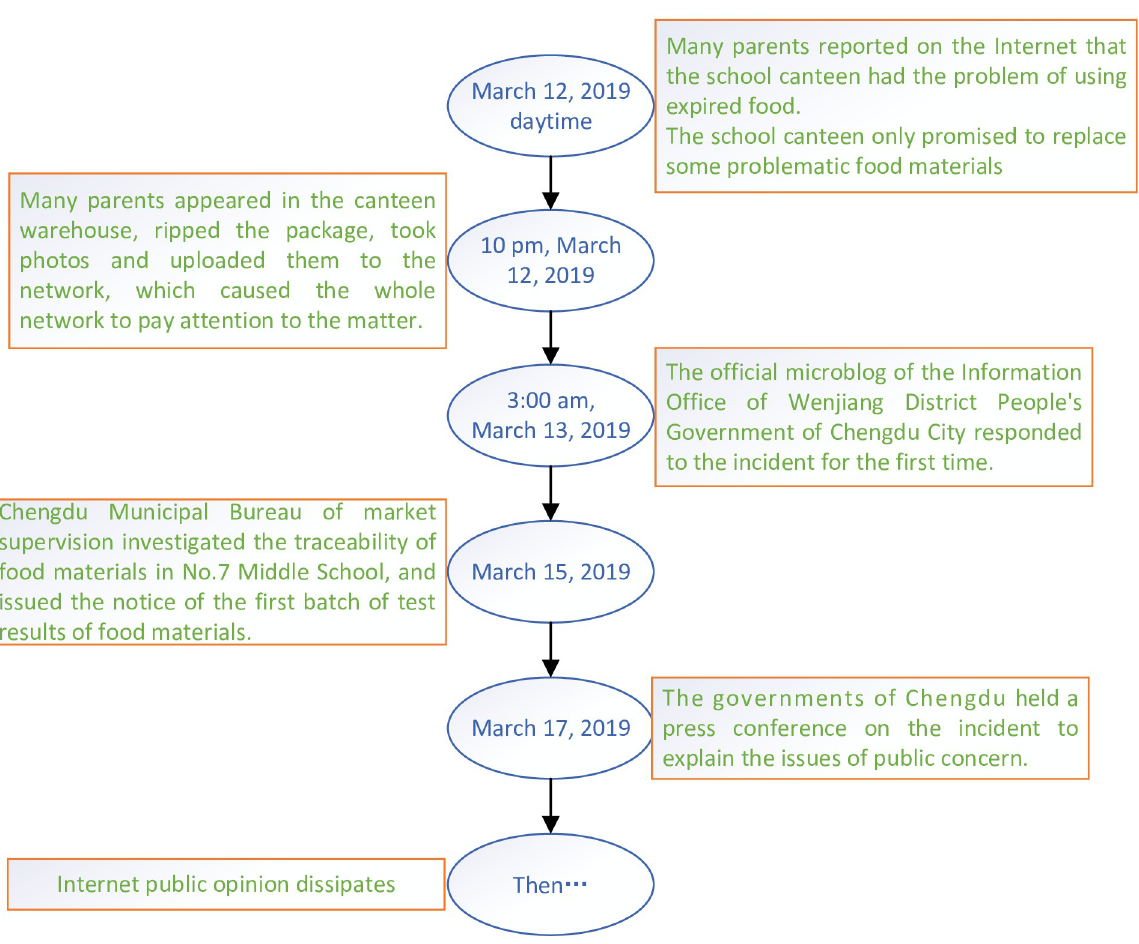
Fig 8. The process of a realistic